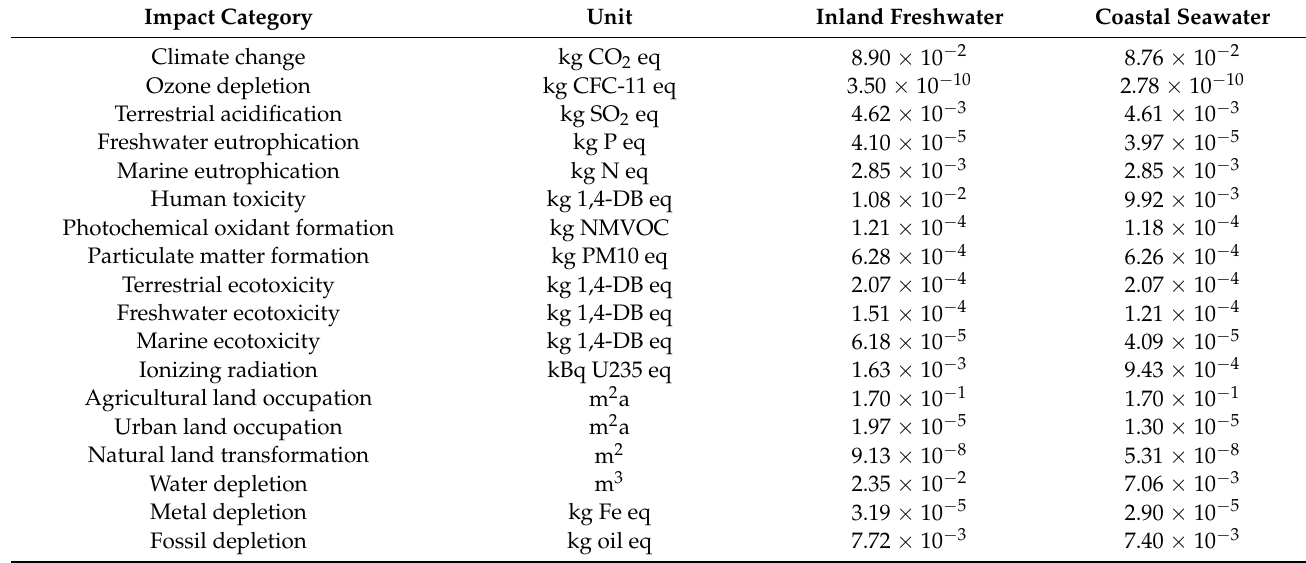
Table 5. Complete life cycle environmental impacts of the two scenarios of bioethanol production for the beet washing step